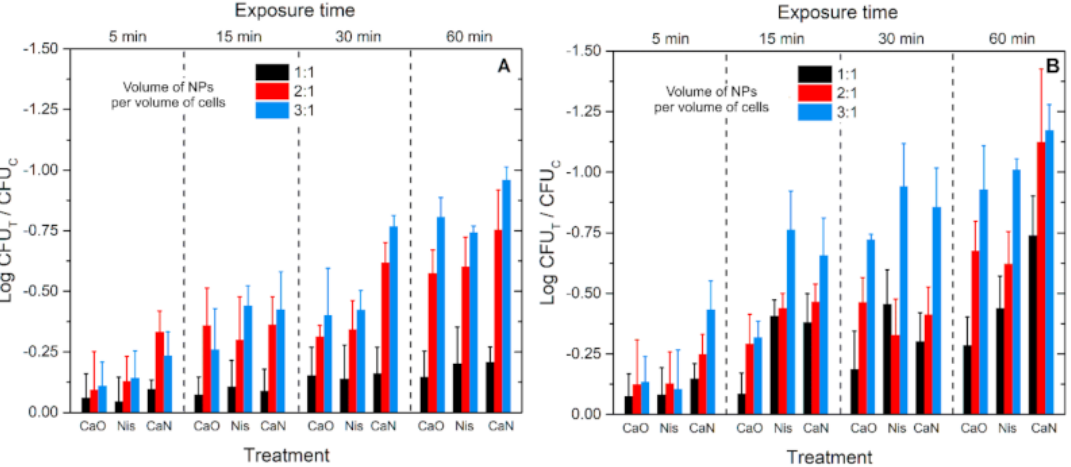
Figure 6. The viability response of L. innocua to thermal stress and nisin-loaded (CaN), nisin-free (CaO) magnetic nanoparti- cles or nisin-only solution (Nis). ( A ) 37 ◦ C experiments; ( B ) 45 ◦ C experiments. In all cases the treatment data (CFU T ) are normalized to untreated control samples (CFU C